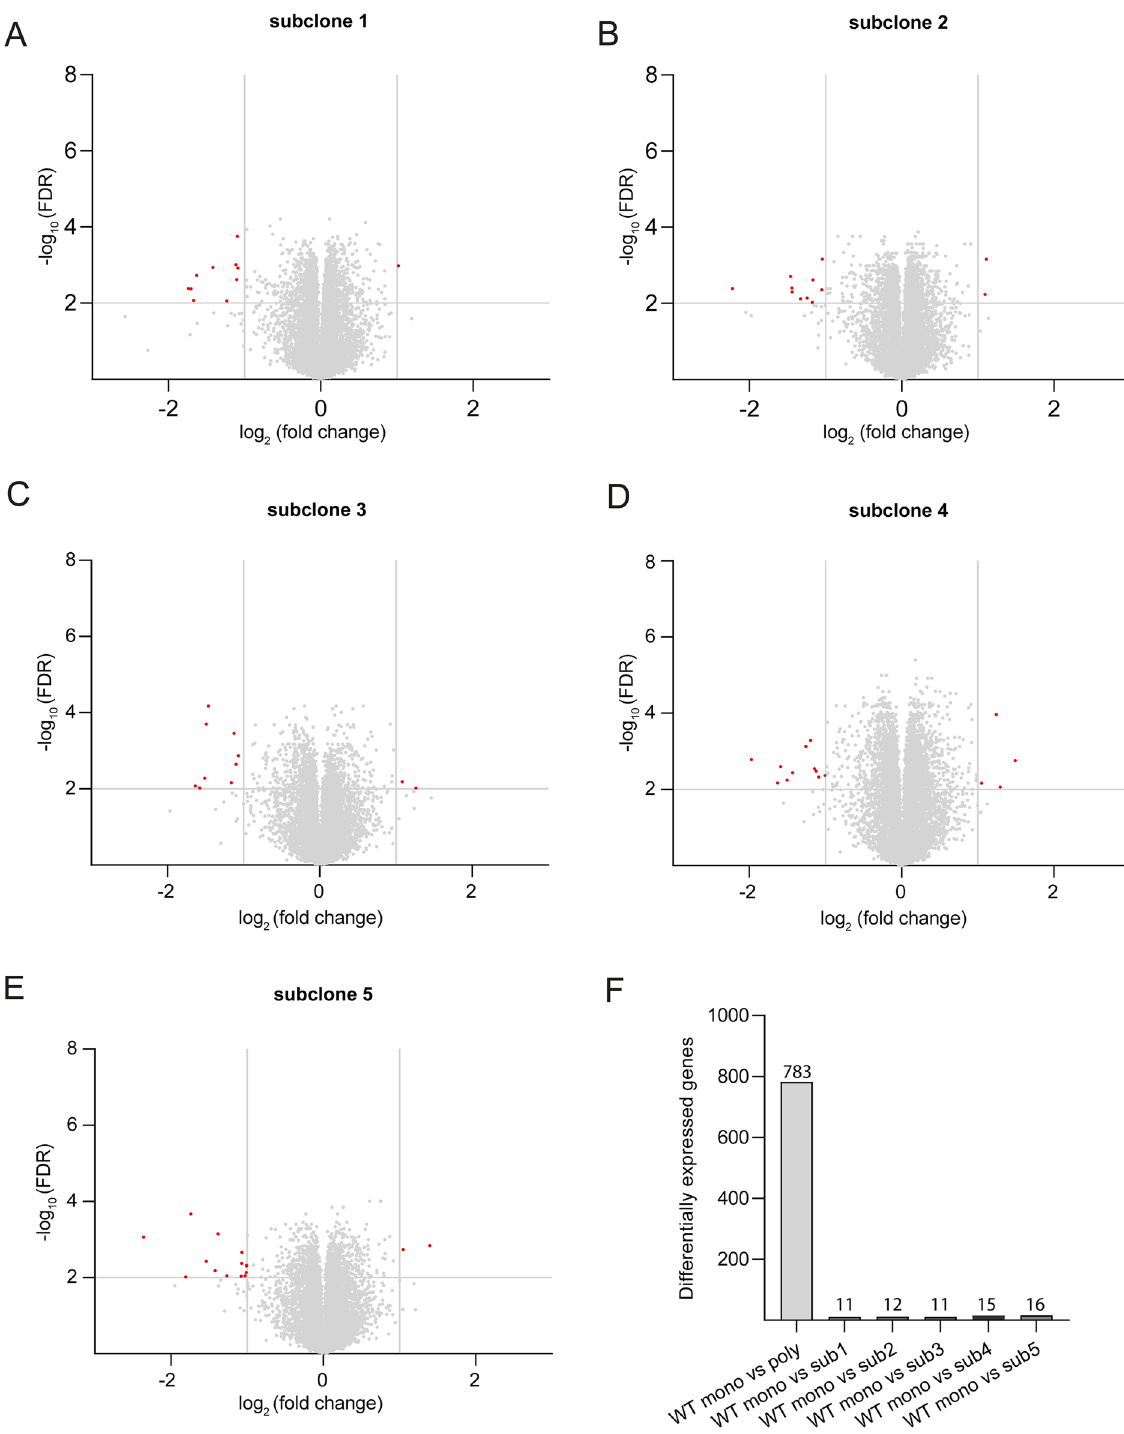
Figure 5. Monoclonal wild-type cell line and corresponding subclones show similar transcriptomic profiles in contrast to the polyclonal wild-type. Volcano plots with differentially expressed genes in five different subclone cell lines of the parental monoclonal cell line in comparison with the parental monoclonal cell line ( A – E ). A bar chart ( F ) summarizes total amount of differentially expressed genes comparing parental cell line with polyclonal wild-type cell line as well as subclones with parental cell line. Threshold for false discovery rate (FDR) was set to log 10 ≥ 2. Threshold for fold change was set to log 2 ± 1. Grey dots represent genes which do not meet threshold criteria (FDR log 10 < 2 and/or log 2 (fold change) between ±